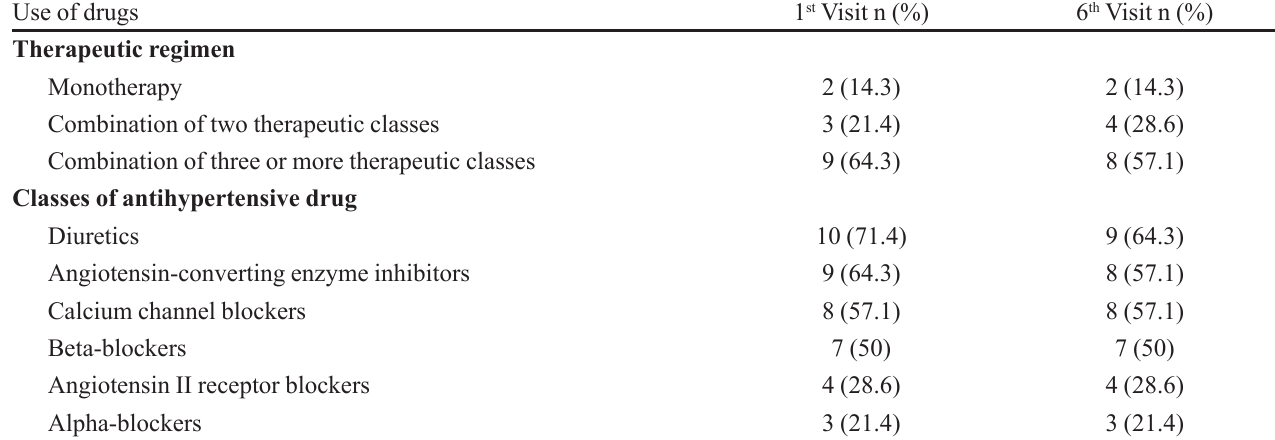
TABLE III - Use of antihypertensive drugs by hypertensive patients receiving care within the Family Health Strategy Use of